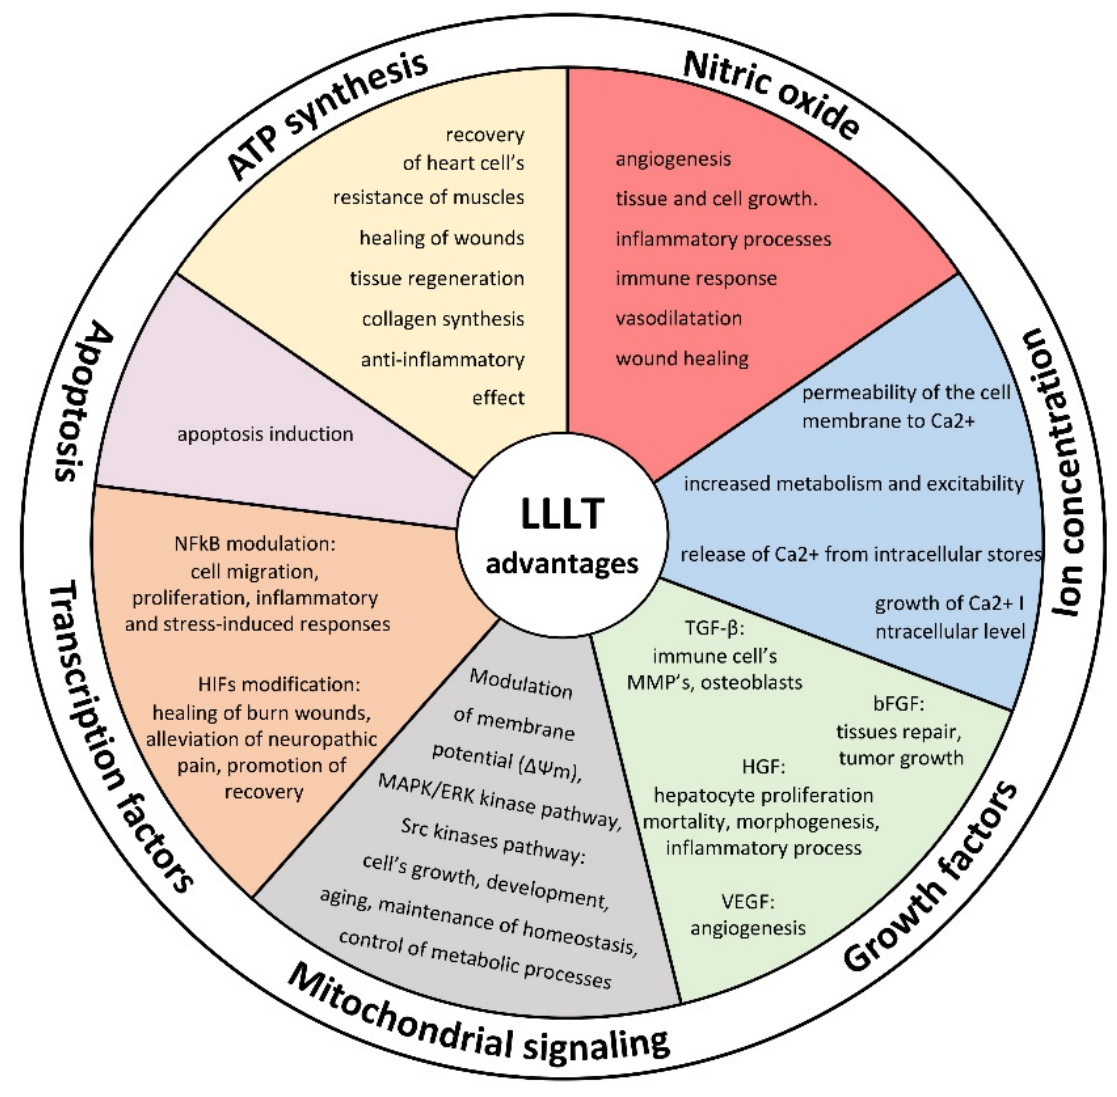
Figure 1. Mechanism of LLLT action on cell activity and potential advantages of laser therapy on cell biology.